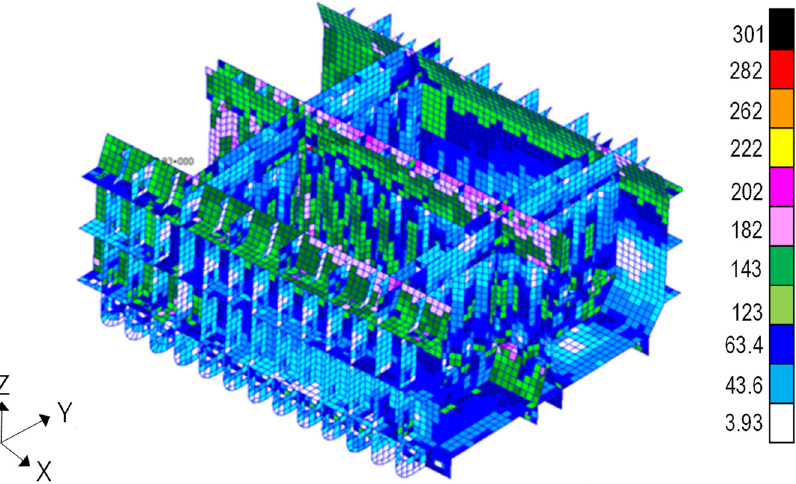
Figure 11. Von Mises stress contour of the inner cargo structure under hogging combinations.